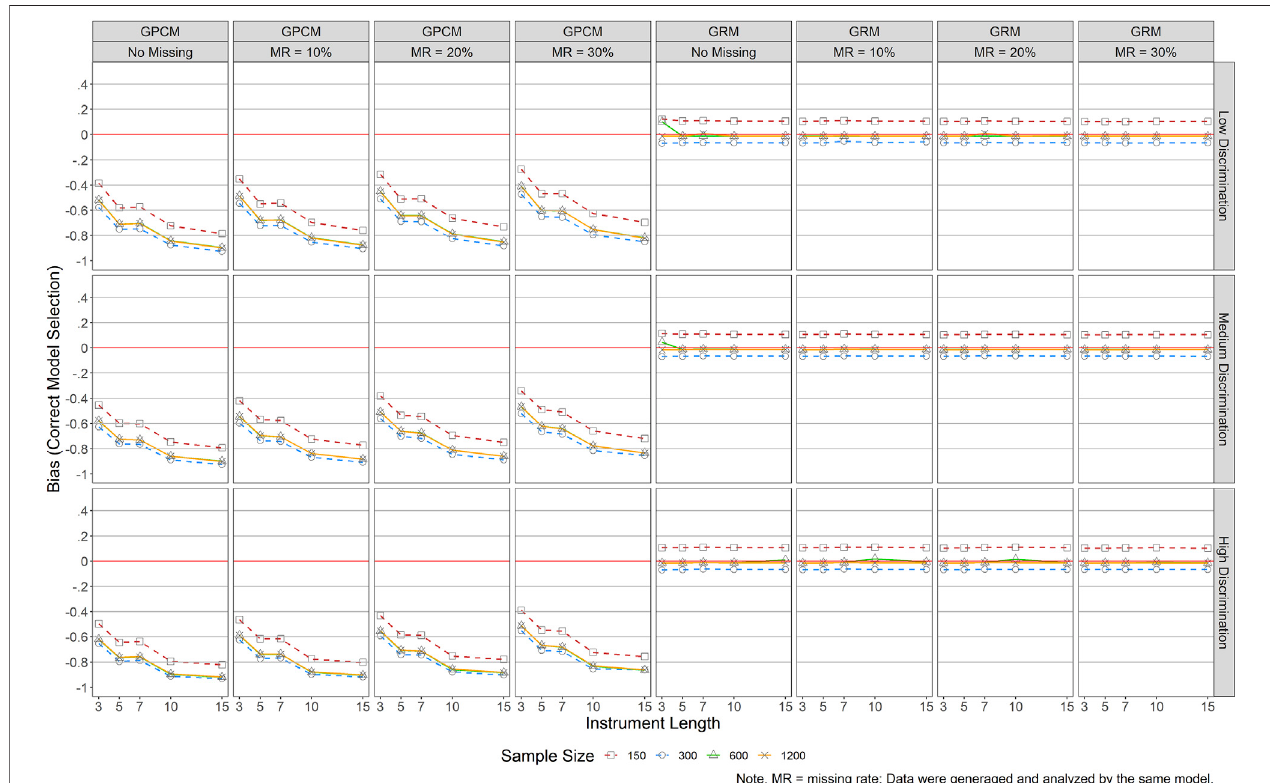
FIGURE6| BiasResultsofPersonParameterEstimationsforBothGRMandGPCM(correctModelSelection).Note.MR (cid:1) missingrate;Dataweregeneragedand analyzed by the same model.